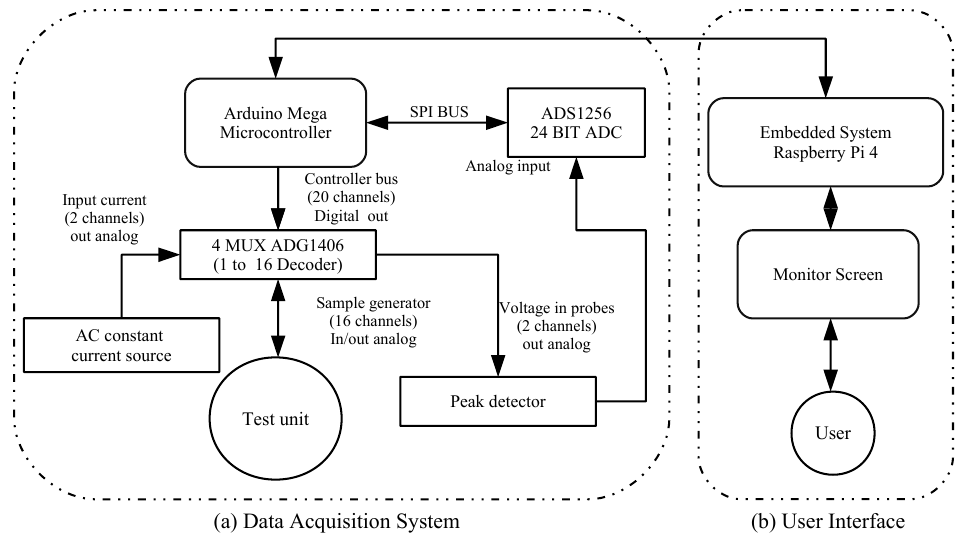
Figure 4. Block diagram of the proposed electrical impedance tomography (EIT) system. ( a ) Data acquisition stage, ( b ) User